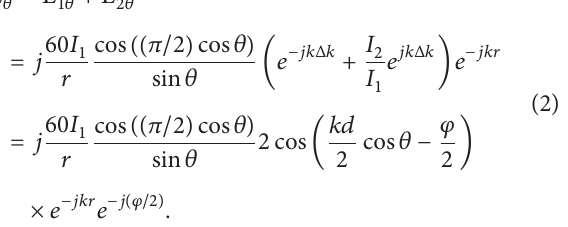
Figure 1: Geometries of the proposed antenna. (a) Four-element arrays and (b) top layer and bottom layer of one element.